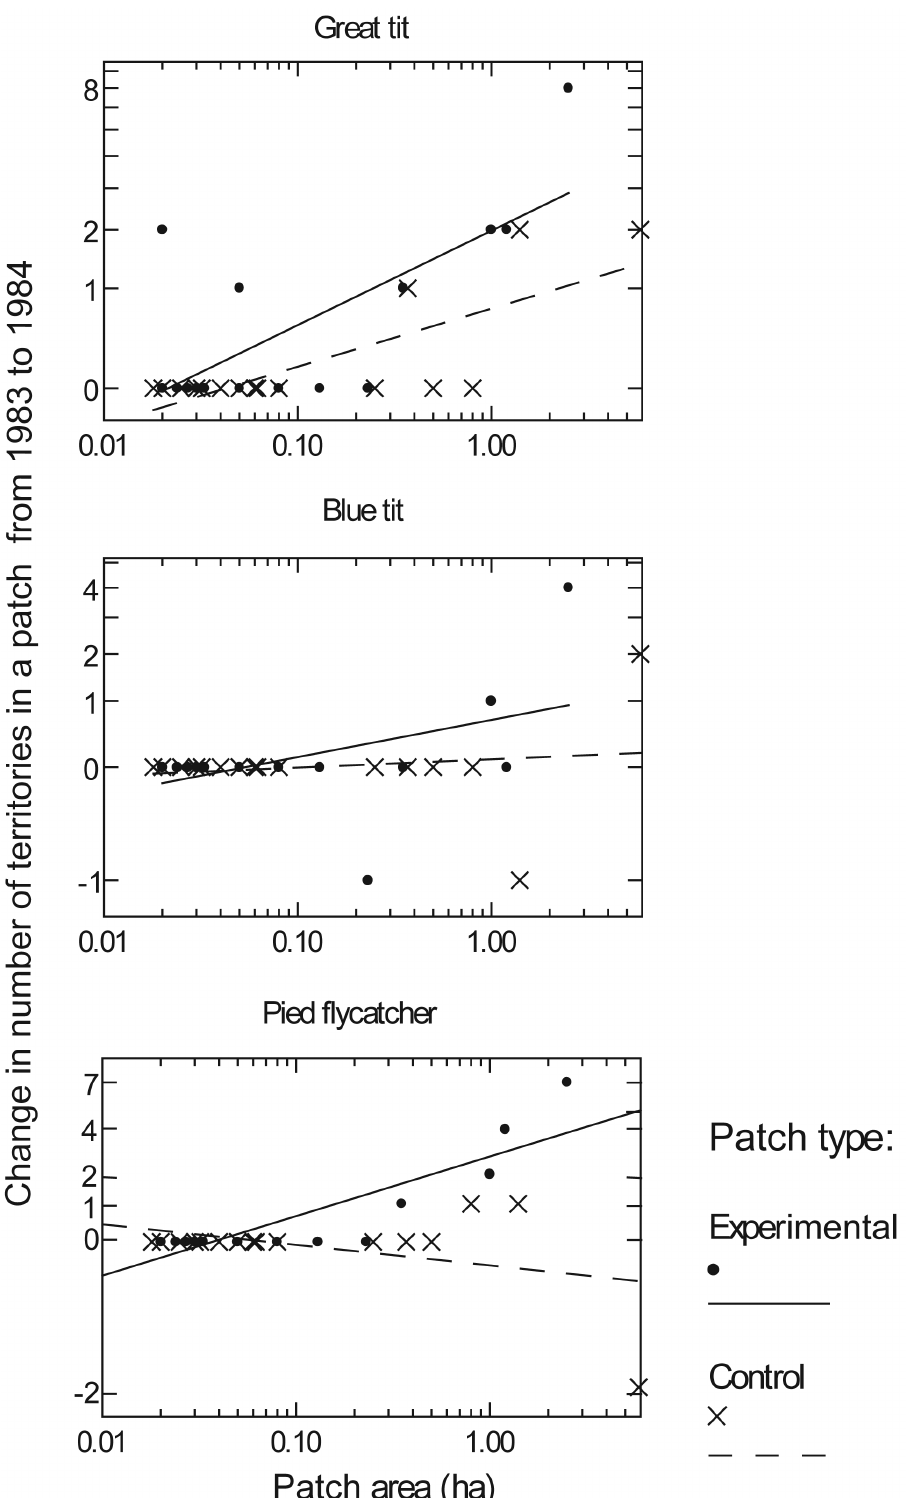
Fig. 3. Change in territory numbers from 1983 to 1984. Each symbol represents one